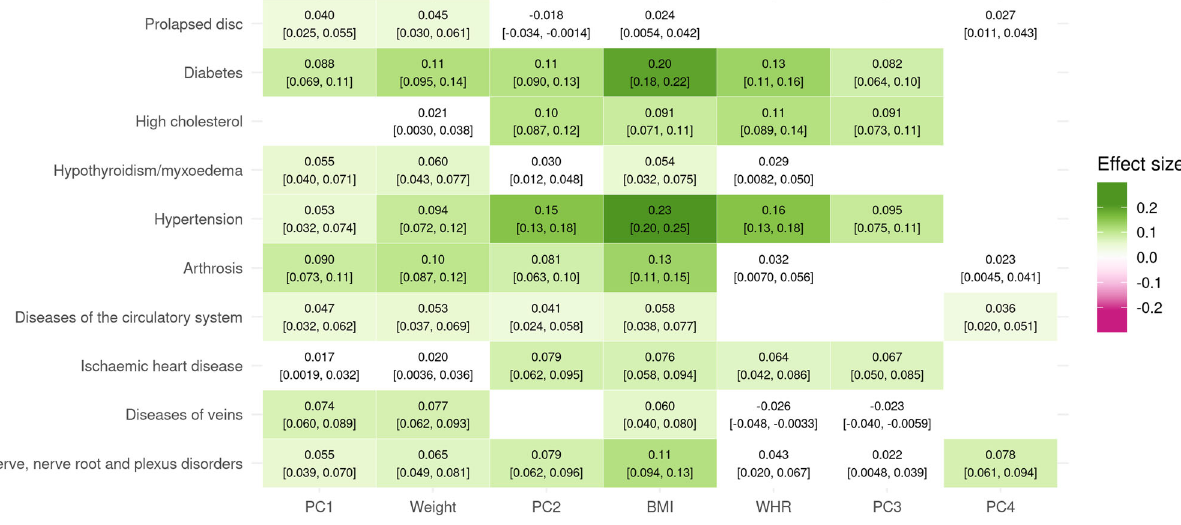
COMMUNICATIONS BIOLOGY| (2021) 4:1064